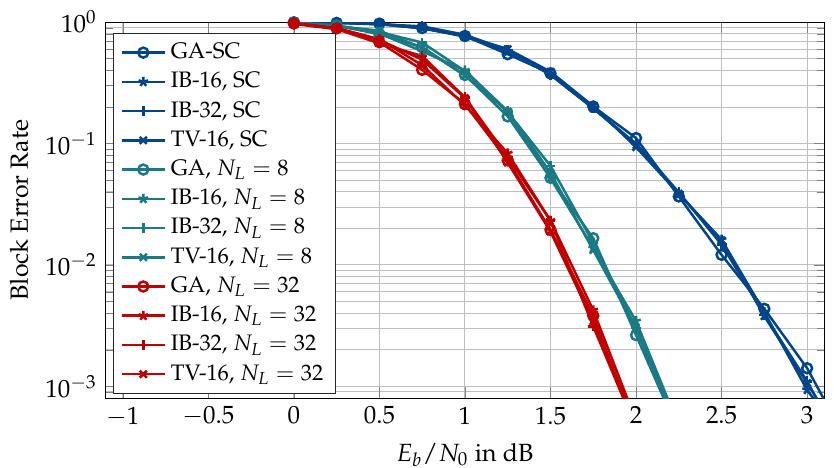
Figure 14. Block error rate of polar codes constructed using Gaussian approximation, Tal and Vardy’s method, and the information bottleneck method using a conventional successive cancellation (SC) and successive cancellation list (SCL) decoder with N L = 8,32, 16-bit cyclic redundancy check (CRC), N = 1024, rate 0.5, and design E b / N 0 = 3